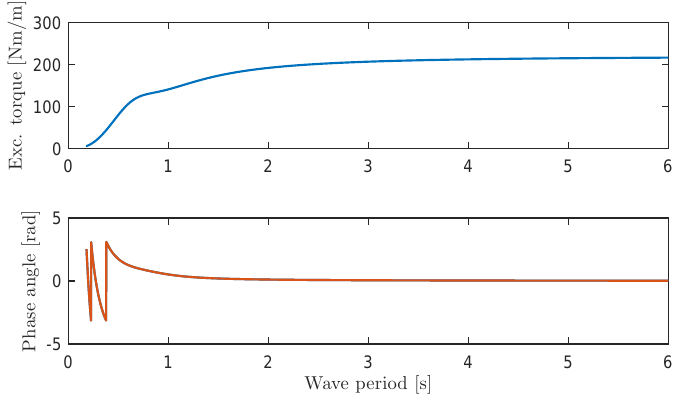
Figure 4. Hydrodynamic excitation torque on the experimental